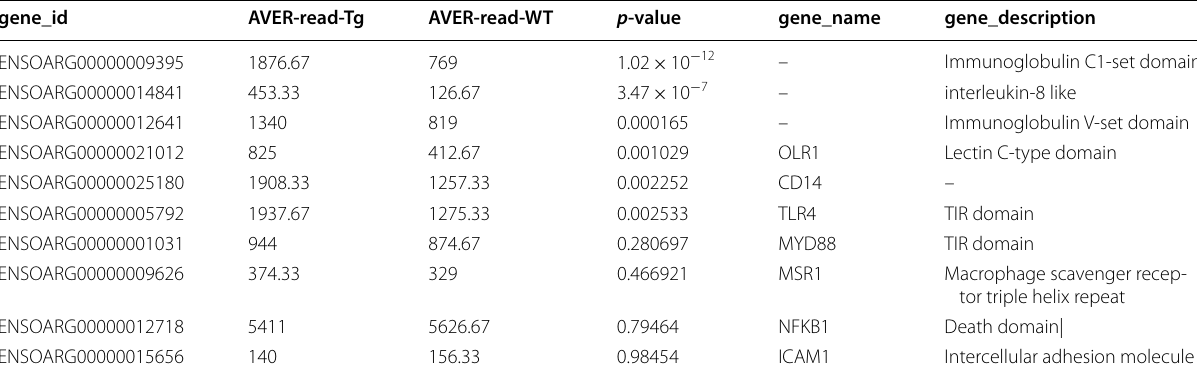
Table 2 Immunoglobulin and internalization-associated genes expression in ovine Peripheral Blood Mononuclear Cells